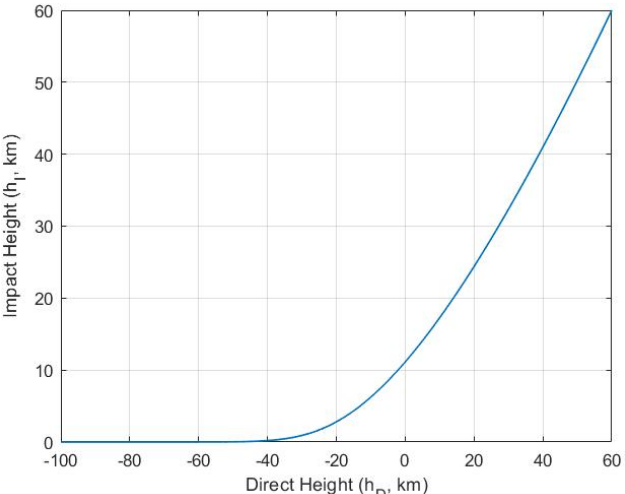
Figure 2. The estimated functional relationship between impact height and direct height as derived from COSMIC-2 RO observations.